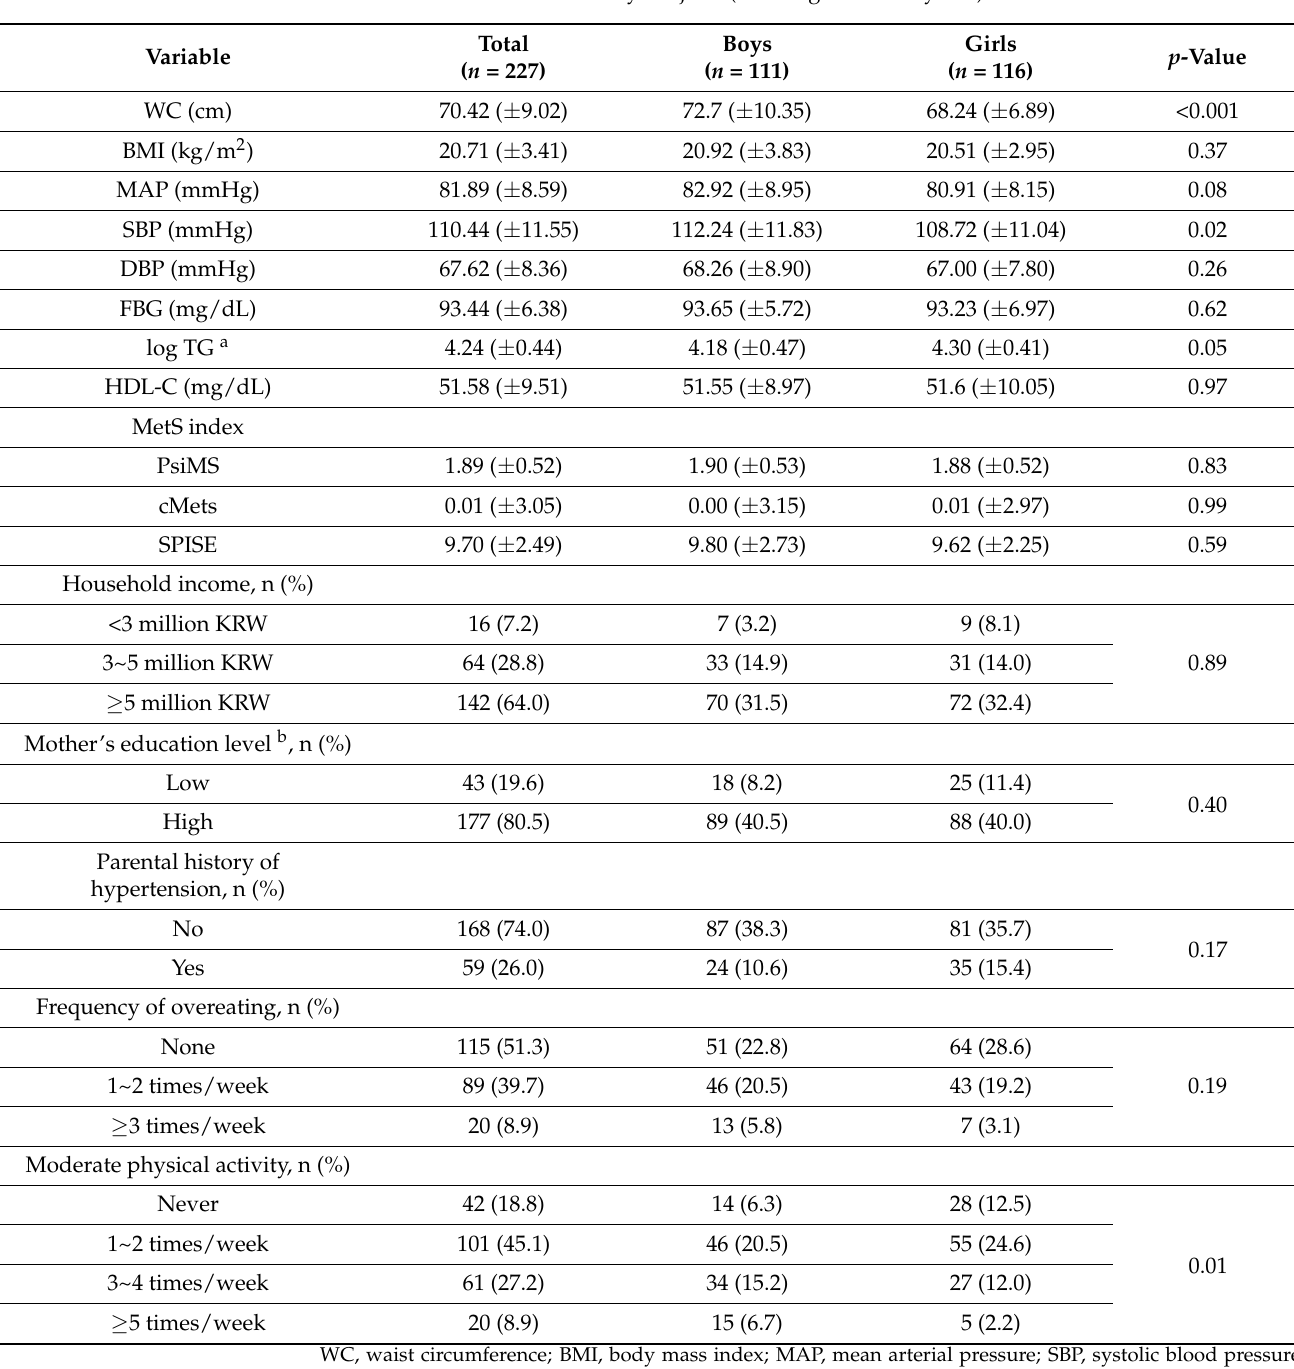
Table 2. Characteristics of study subjects (at the age of 13–15